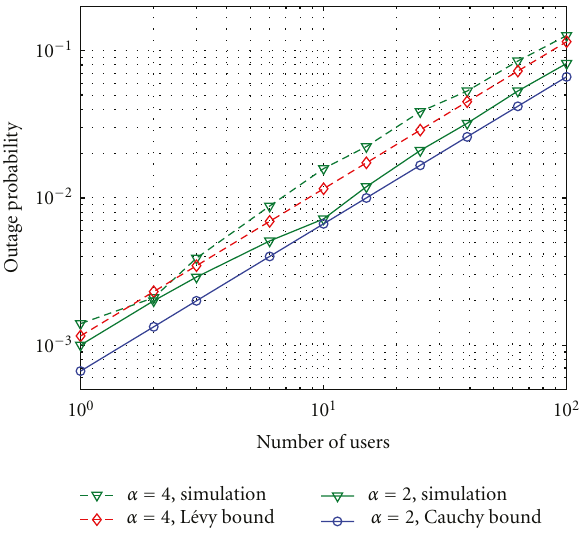
Figure 5: The outage probability P out versus the number of users N u in AWGN channels with interference avoidance, where Cauchy bound and α = 4 for L´evy bound, N s = 4.